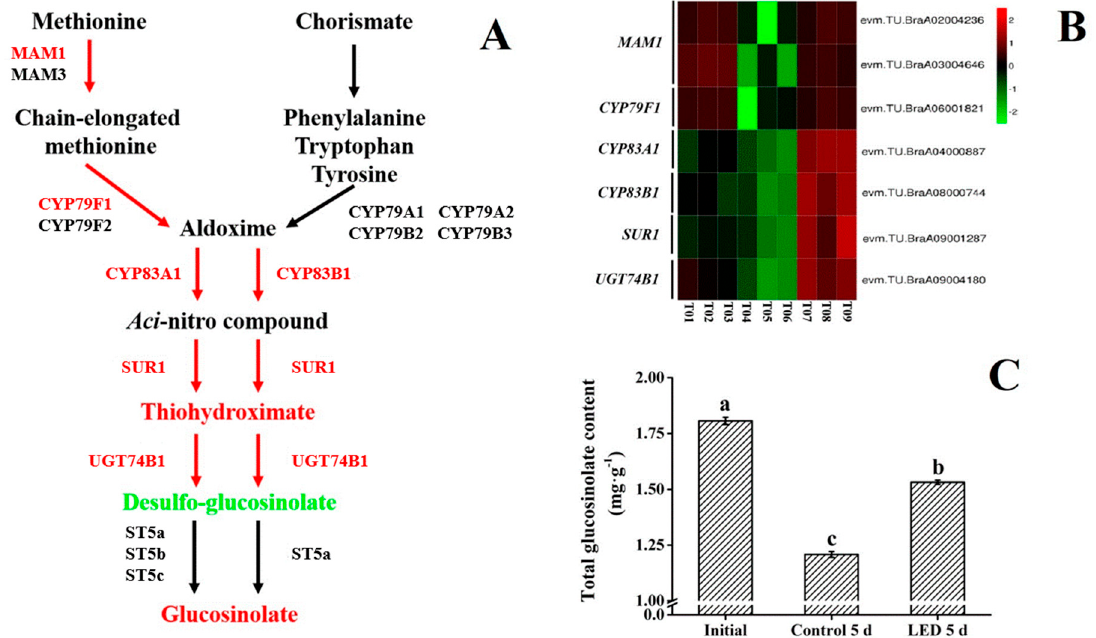
Figure 4. The effect of LED irradiation on the expression of genes in pak-choi involved in the biosynthesis of glucosinolate and levels of total glucosinolate. ( A ) Metabolites or genes expressed at a higher level in the LED treatment group, relative to the dark-stored (control) treatment group, are illustrated in red. Metabolites or genes expressed at a lower level in the LED treatment group, relative to the dark-stored (control) treatment group, are illustrated in green. ( B ) Expression pattern of genes involved in glucosinolate biosynthesis in response to LED irradiation. Seven DEGs (FC ≥ 2; FDR ≤ 0.01) associated with photosynthesis were identified. Log2 based FPKM value were used to generate the heat map. The scale represents the relative signal intensity of FPKM values (T01, T02, T03: initial; T04, T05, T06: dark-stored control 5d; T07, T08, T09: LED treatment 5d). ( C ) Level of total glucosinolate in pak-choi in the three treatment groups (initial, dark-stored control 5d, and LED treatment 5d) of pak-choi. Vertical bars represent the standard error of the mean ( n = 3). Means denoted by the same letter do not differ significantly at p < 0.05 as determined by LSD’s multiple range test. Metabolomic data indicated that levels of S-(Indolylmethylthiohydroximoyl)-L-cysteine (SLC) and glucoiberverin in the LED treatment group were higher than in the other two treatment groups,